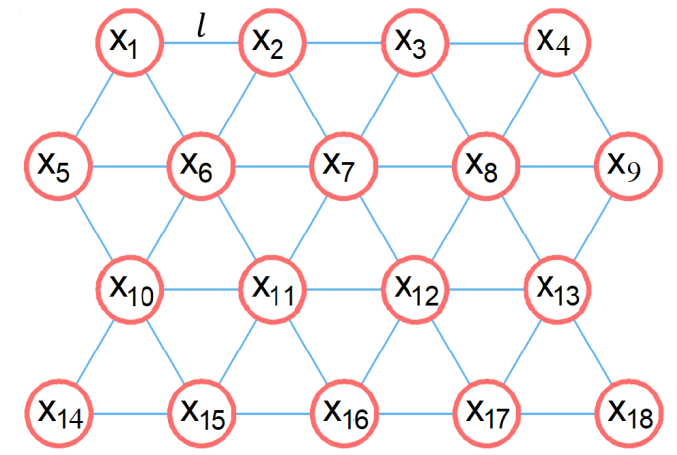
Figure 1. Graph with triangular cells.